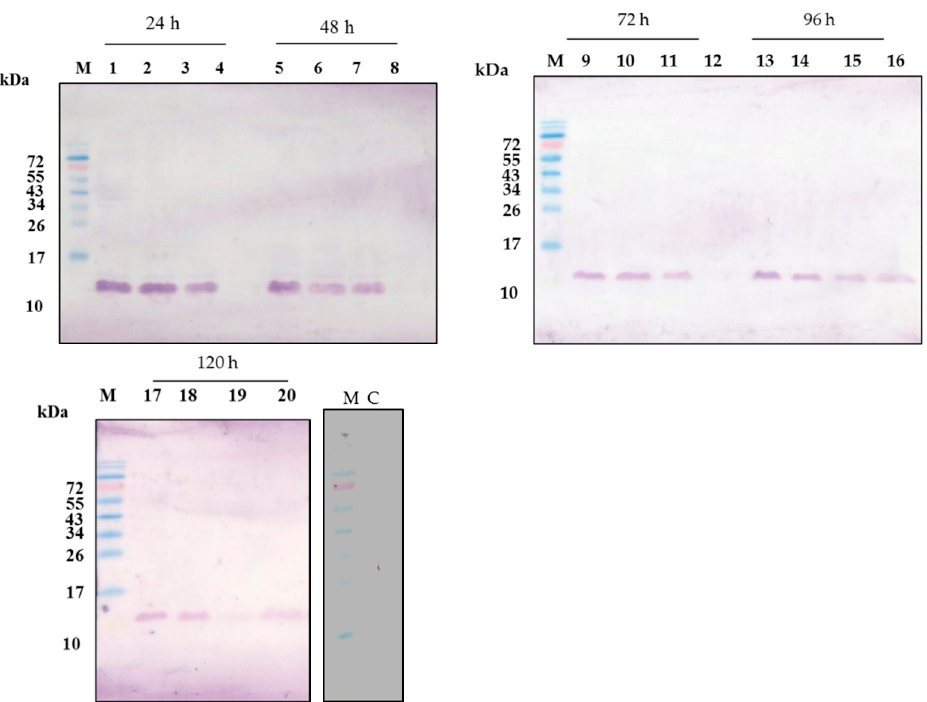
Figure 2. Western blot of pGAPZaC-prepro-cecB2/ P. pastoris SMD1168. Lane M, molecular weight markers (kDa); Lane C: control (cell crude extract of pGAPZaC/ P. pastoris SMD1168) lane 1–4, crude extract, pellet, supernatant, 100 × concentrated extracellular fluid, at 24; lane 5–8, the same items at